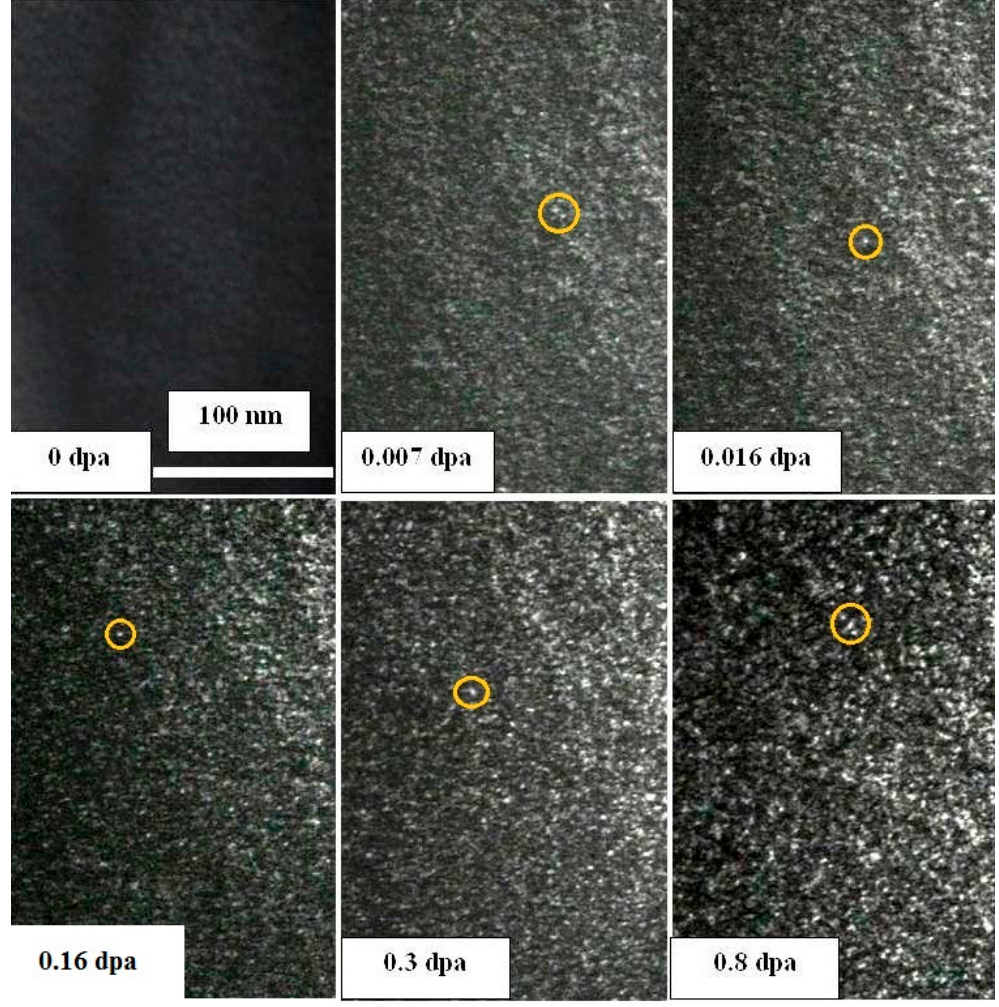
Figure 5. Series of dark field micrographs, taken during in situ irradiation experiment on Zircaloy-2 at 573 K, showing the formation of <a>-type loops, which present as bright dots in dark field. The orange circles in each micrograph enclose one or more dot-like loops.